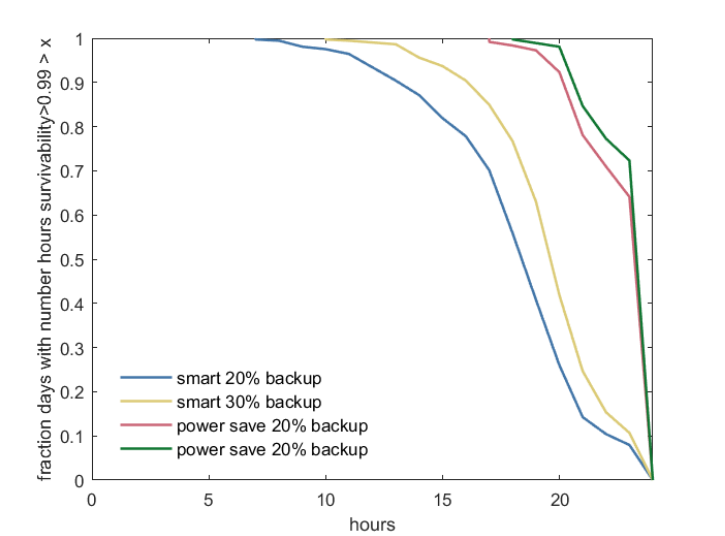
Figure 9. Complementary experimental cumulative distribution of the number of hours per day with a survivability larger than